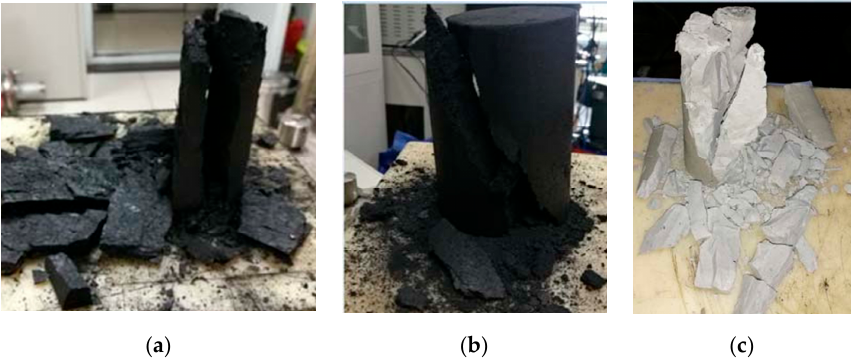
Figure 15. Failure forms of three coal and rock materials. ( a ) Raw coal; ( b ) shaped coal and ( c ) cement.